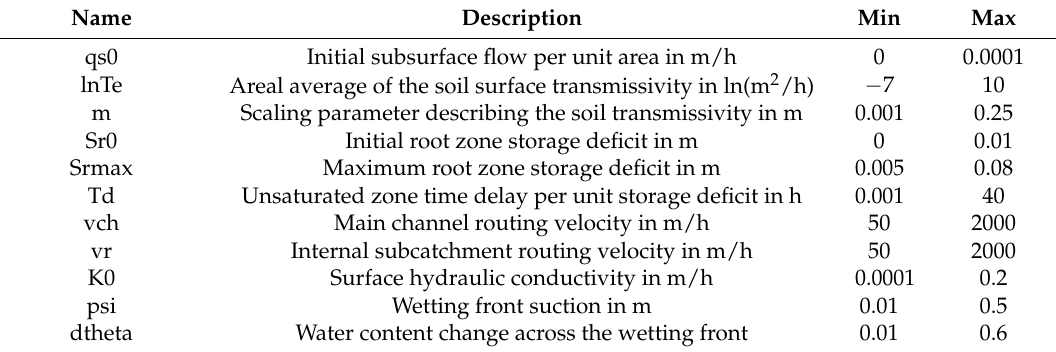
Table 1. r.topmodel parameters and their ranges for uncertainty